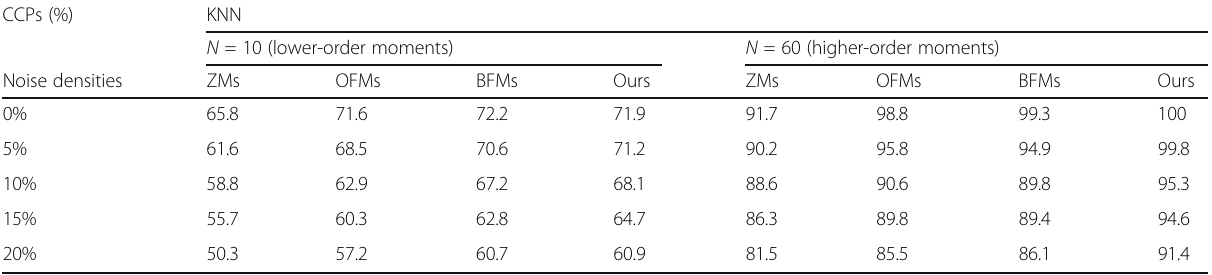
Table 4 Comparative study of the CCPs by various methods (including classic ZMs, OFMs, BFMs, and ours) for D1 dataset contaminated by salt and pepper noise CCPs (%) KNN N = 10 (lower-order moments)